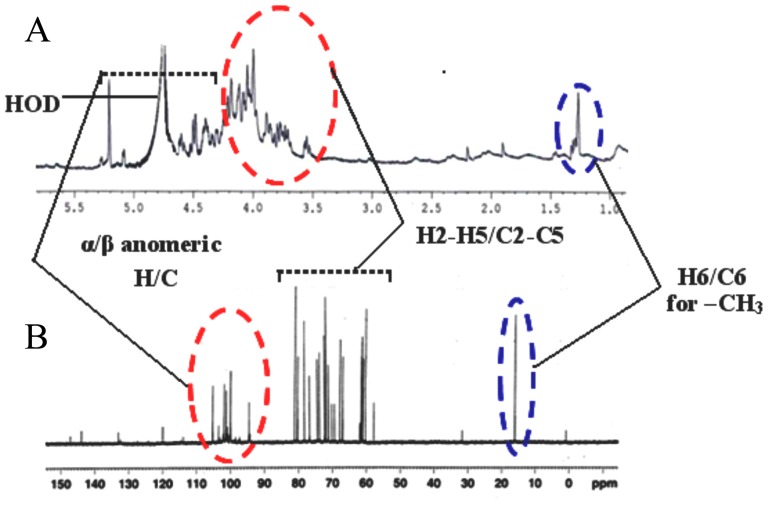
Partial structure elucidation of HFC polysaccharide by NMR spectroscopy.The purified samples were exchanged with deuterium by lyophilizing several times with D2O. The polysaccharide was dissolved in 0.7 mL of D2O (99.96%) at concentrations of 15 mg/mL (for 1H NMR) and 30 mg/mL (for 13C NMR). Spectra were run at a probe temperature of 40°C. A) in the 1H NMR spectrum, black dotted line indicating α and β proton anomers, and dotted circles displaying H2–H5 and H6 (–CH3 group) of the polysaccharide directed from downfield to upfield. B) in the 13C NMR spectrum, downfield dotted circle stands for α and β carbon anomers, black dotted line indicating C2–C5, and upfield dotted circle signifying C6 (–CH3 group) of the polysaccharide.